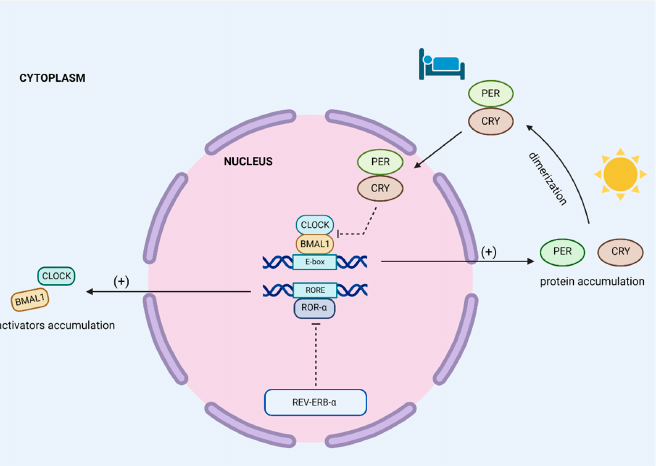
Figure 1. Core circadian clock mechanism. There are two main feedback loops. CLOCK and BMAL1 are transcription factors which act as activators. They work as heterodimers and bind to E-box se- quences in DNA, leading to a large number of gene transcriptions, such as PER , CRY , and REV-ERB- α . PER and CRY proteins accumulate during the daily cycle in cells’ cytoplasm. Their highest levels occur before sleep. Following this process, they form a dimerm which is translocated to the nucleus. PER-CRY dimers exhibit repressor activity via the inhibition of CLOCK-BMAL1. This is a basic neg- ative feedback loop that regulates the circadian clock. The second feedback mechanism of the core clock is composed of ROR- α and REV-ERB- α proteins. ROR- α binds to RORE sequences in DNA and promotes the transcription of activators such as CLOCK and BMAL1. REV-ERB- α is a repressor because it inhibits ROR- α activity. BMAL1—brain and muscle ARNT-like 1, CLOCK—clock circadian reg-